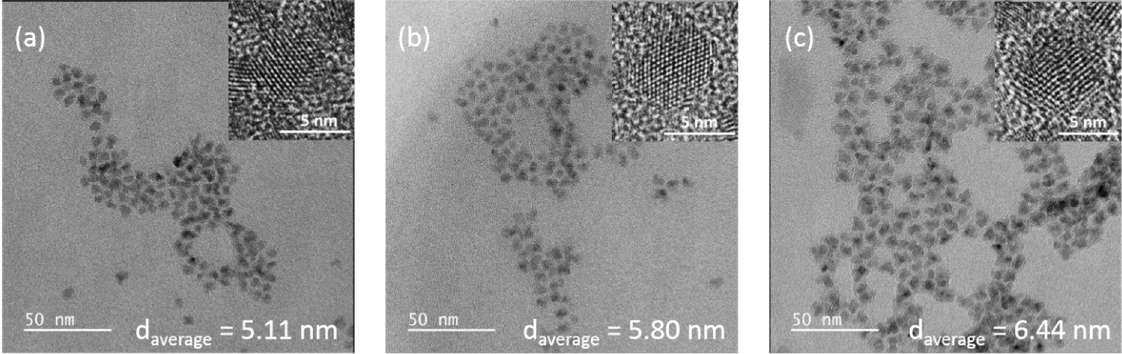
Figure 3. TEM and HRTEM (inset) images of Cd 0.25 Zn 0.75 Se/ZnS 1 ML ( a ), Cd 0.25 Zn 0.75 Se/ZnS 2 MLs ( b ), and Cd 0.25 Zn 0.75 Se/ZnS 3 MLs ( c ).